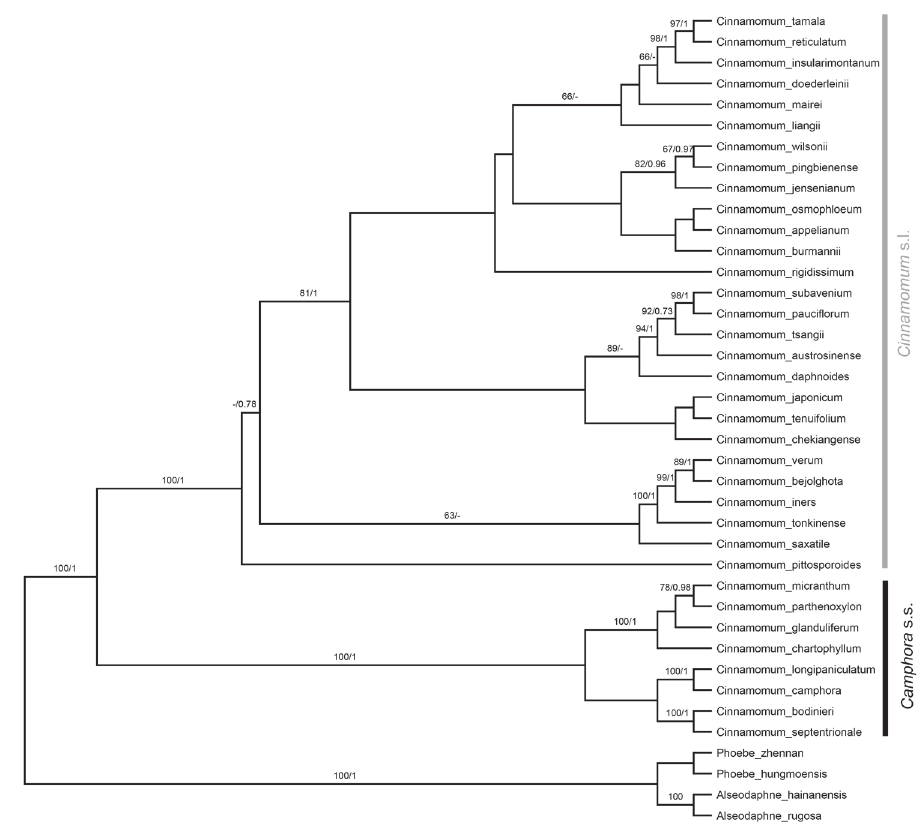
Figure 9. Phylogeny of the Asian Cinnamomum incorporating ML and BI trees. Upper number of the slash refers to the bootstrap value of the ML tree and the lower number of the slash refers to the posterior probabilities of the BI